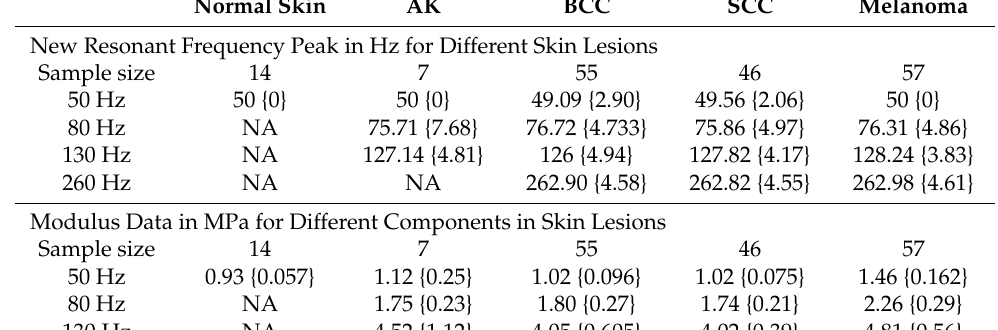
Table 1. Mean resonant frequency peaks in Hz and moduli in MPa for normal skin, AK, BCC, SCC and melanoma based on VOCT data. The standard deviations are shown in parentheses. Note multiple measurements of resonant frequency and modulus were made on some of the large biopsies.